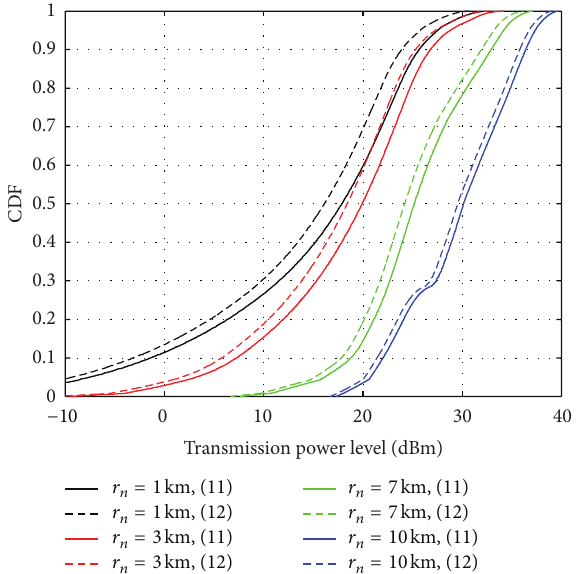
Figure 6: Distribution of UE transmission power levels by using the simplified PF power allocation rule for different protection distances. The power allocation scheme (12) is compared with the power allocation scheme supporting mobility within groups of pixels (13).